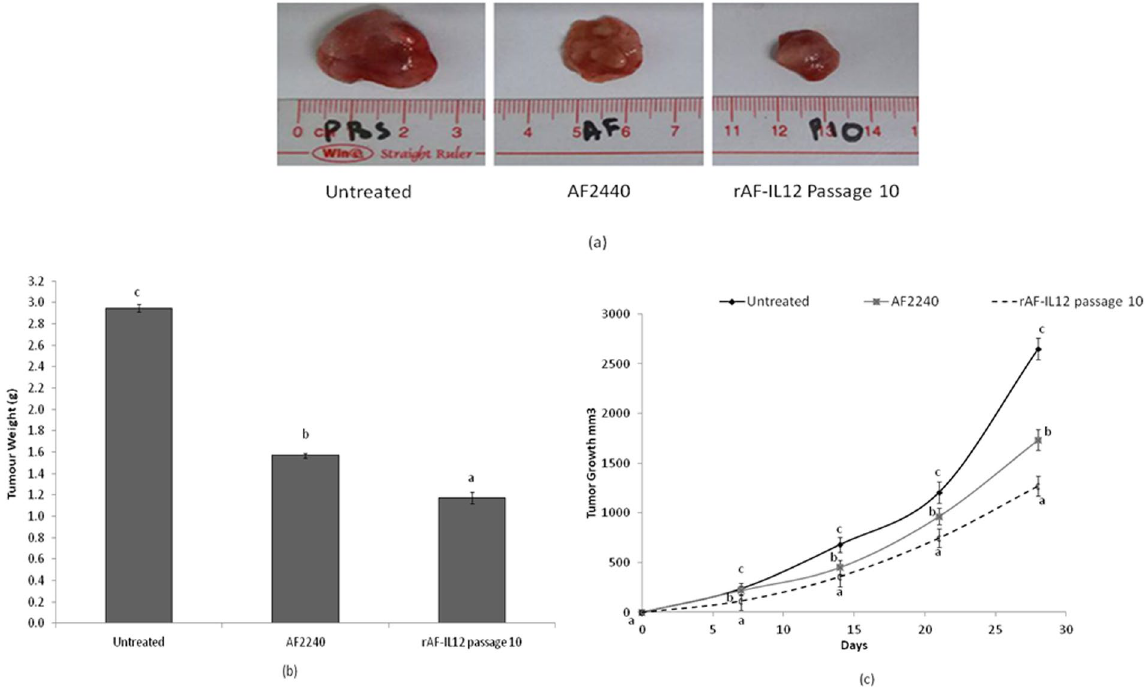
Figure 3. The tumors harvested from untreated, NDV AF2240 and rAF-IL12 passage 10-treated mice (2 7 HAU/kg) mice. ( a ) Representative images, ( b ) average weight and ( c ) volume of the tumors harvested from untreated, AF2240 and rAF-IL12 passage 10-treated mice. Each value represents the mean values ± S.E.M. There were 9 mice per group. The values are expressed as the mean values ± standard deviation of triplicate experiments. The mean values as indicated using different superscript letters were significantly different at p < 0.05 when compared between parental AF2240- and rAF-IL12 (Passages 1, 5 & 10)-treated groups.